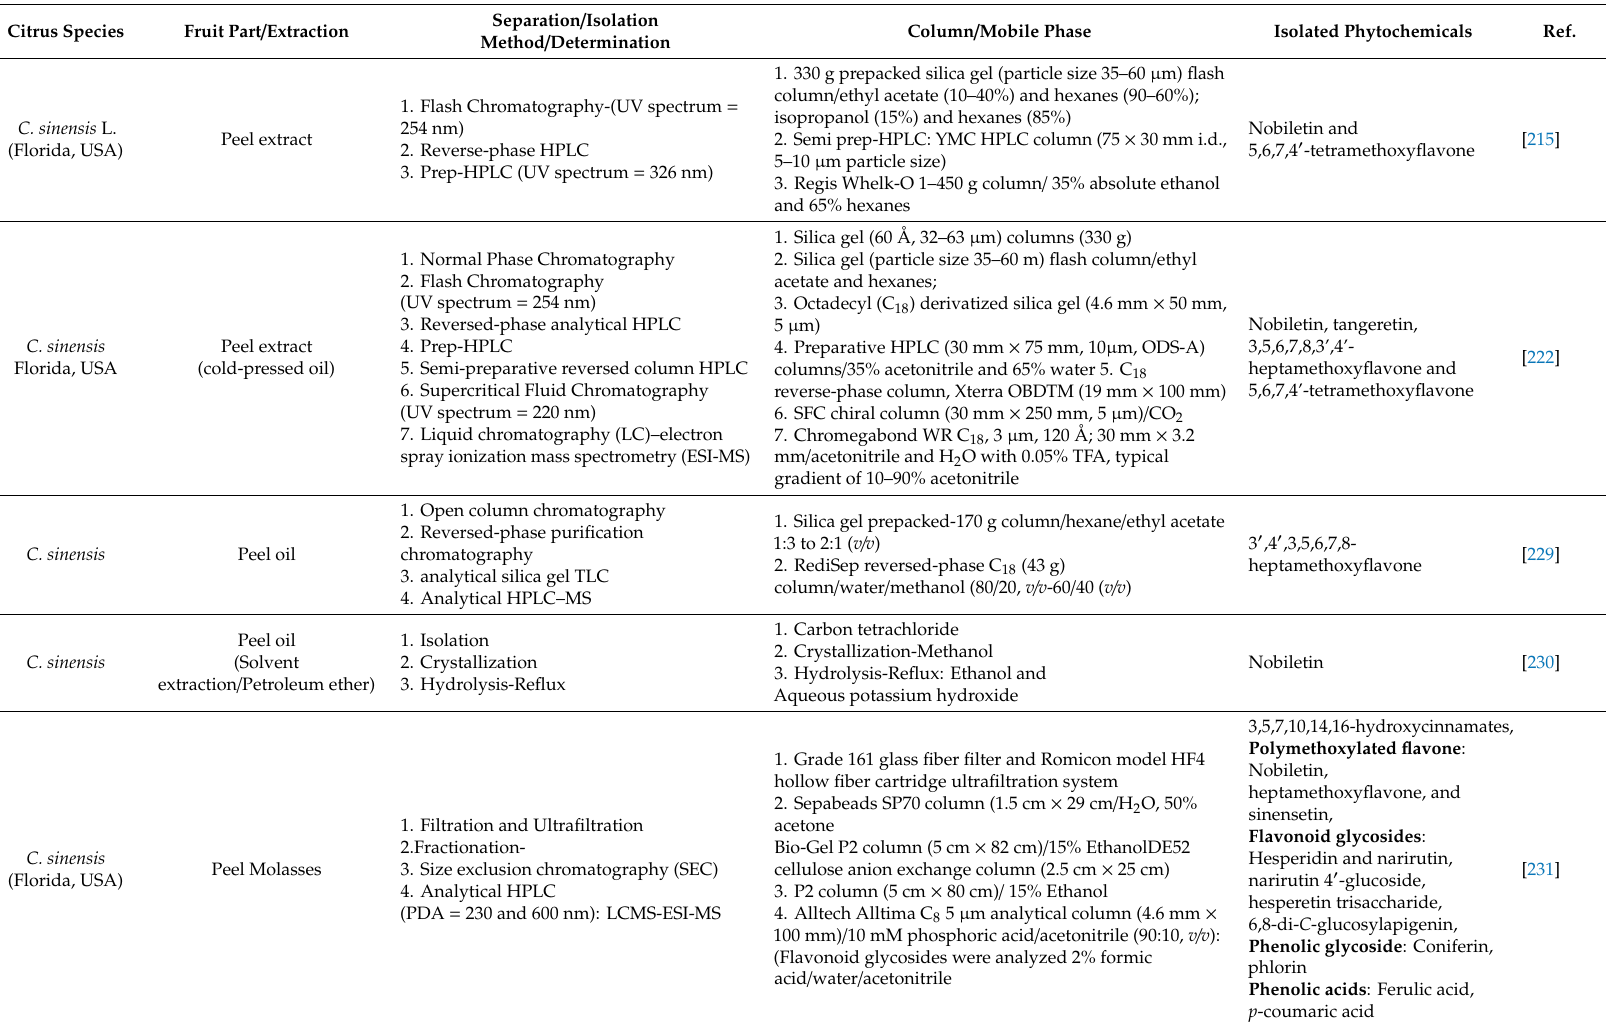
Table 13. Separation, isolation, and purification of citrus phytochemicals from the crude extract obtained from di ff erent extraction procedures. Citrus